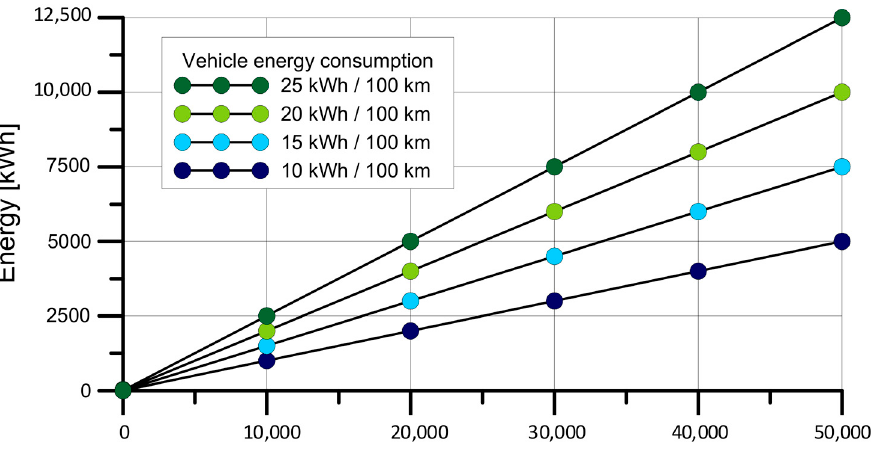
Figure 12. Annual demand for the electric energy of the vehicle with di ff erences in mileage.